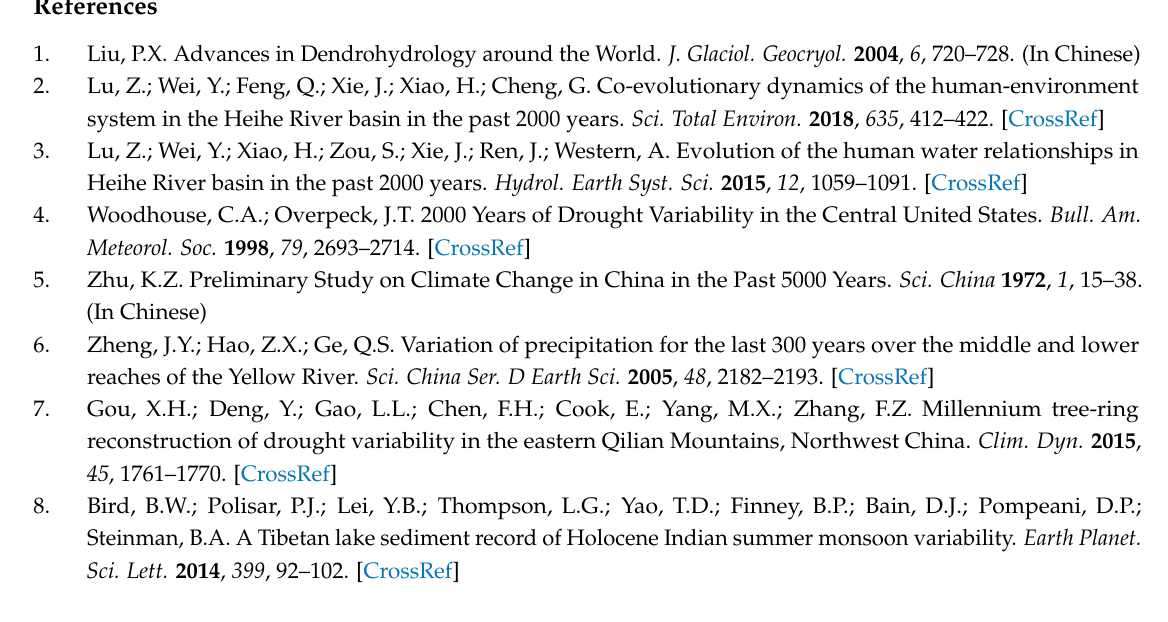
Table S1: The reconstructed precipitations at Wuzhou